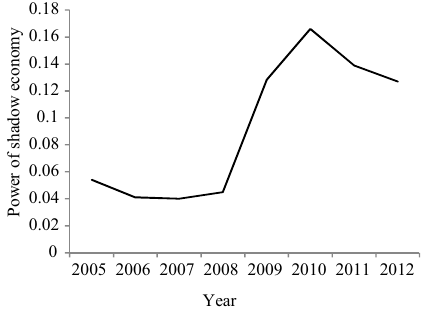
Fig. 2. Growth rate of shadow economy power in